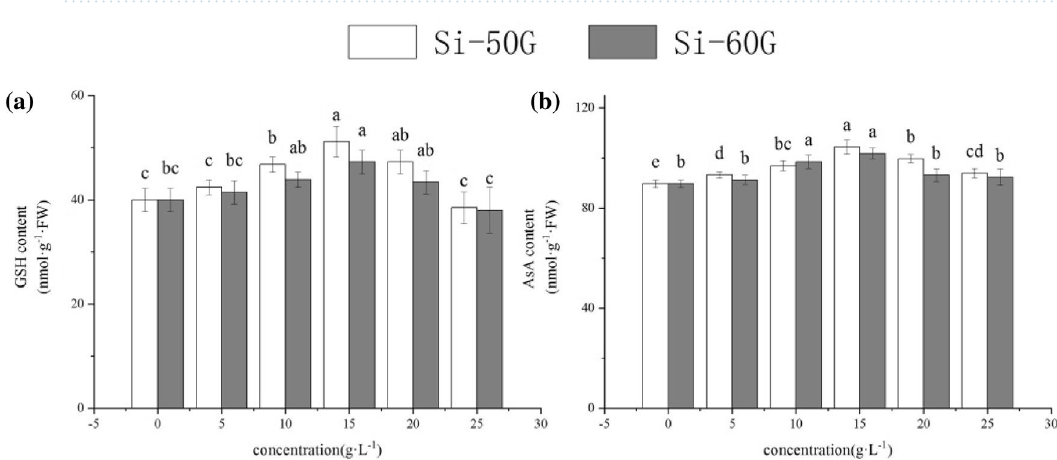
Figure 3. Effects of Si (5, 10, 15, 20, and 25 g·L −1 ) on on non-enzymatic antioxidant contents. The values represent the mean ± SE (n = 4). Mean values provided with error bars representing the standard error. Different letters denote statistical differences at P <